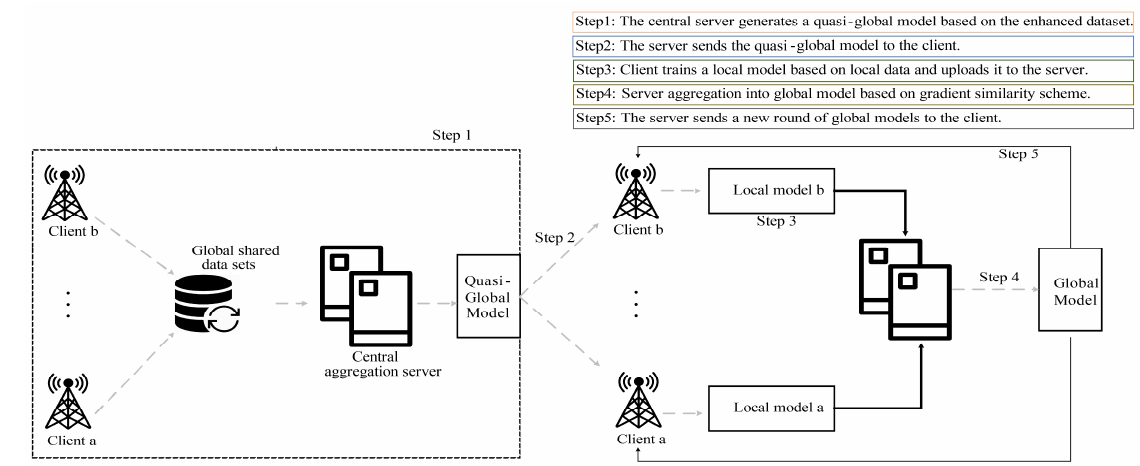
Figure 2. FedGSA Overall Architecture .